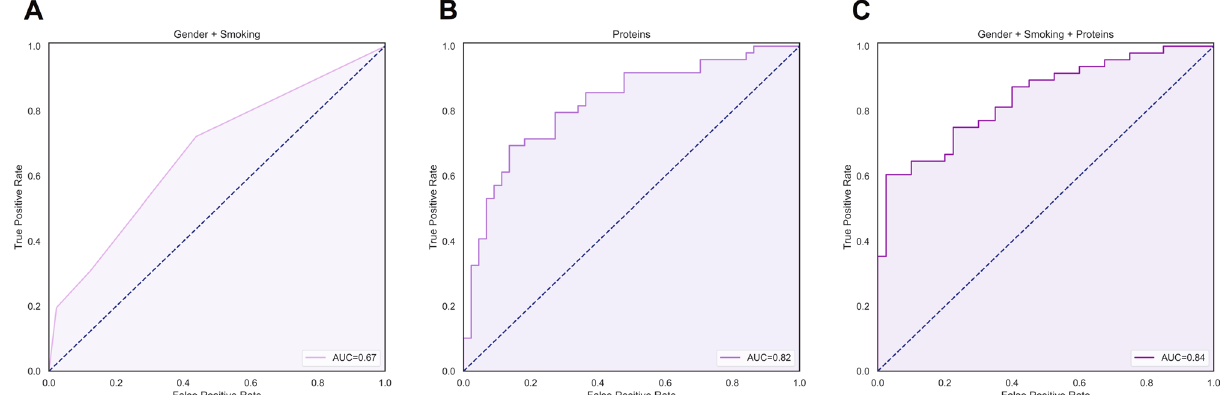
Figure 4. ( A – C ) Receiver operating characteristics (ROC) curves showing the discriminative value of ( A ) gender and smoking as relevant confounding factors and ( B ) a combined panel of seven (7) proteins (consisting of CD5, DNER, EN-RAGE, GDNF, IL-20RA, LIF-R, and VEGF-A) with regard to the presence of fatigue in patients with IBD. ( C ) When combining the seven proteins with gender and smoking as confounding factors, the classification performance increased. Abbreviations: AUC, area under the curve; Q1, first quartile; Q4, fourth